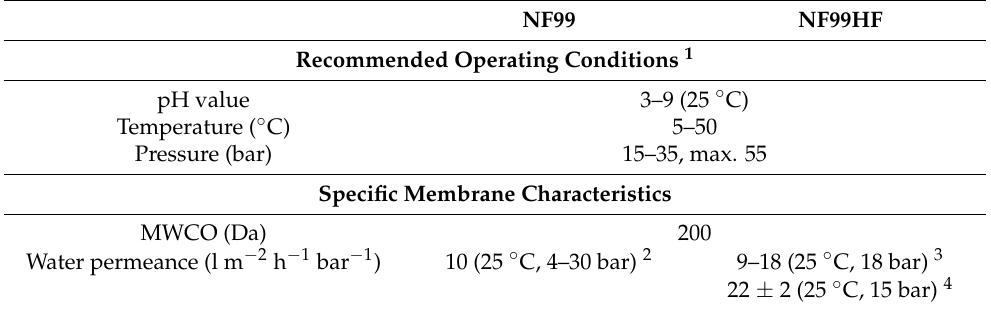
Table 1. Membrane Table 1. Membrane specifications.